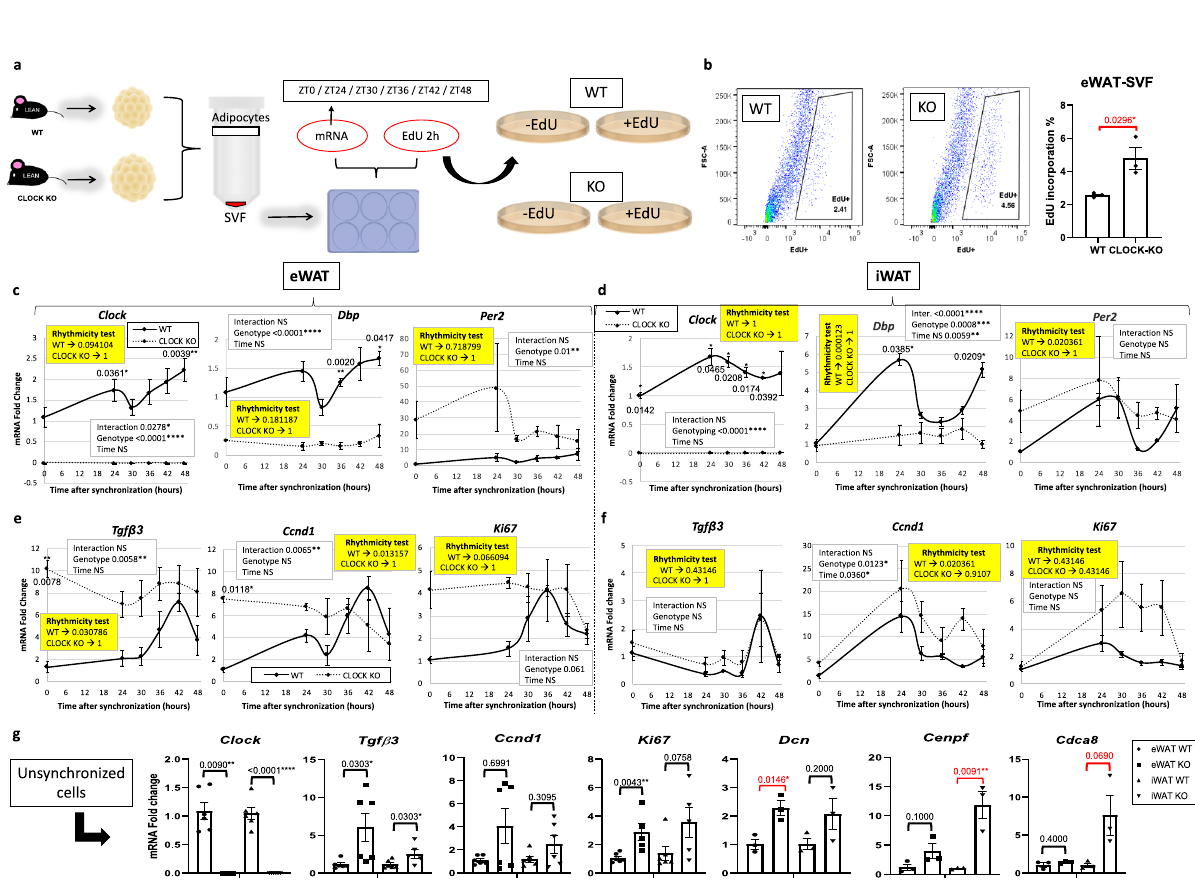
Fig. 6 Clock -de fi ciency induces proliferative markers in epididymal fat (eWAT). a Models of Clock -de fi ciency: eWAT and inguinal fat (iWAT) was collected every 6 h or 5-ethynyl-2 ʹ -deoxyuridine (EdU) was administered at zeitgeber time (ZT) 0 and eWAT and iWAT stromal vascular cell fractions (SVF) were isolated from fat 4 h later. b Energy intake of Clock KO and WT littermates under 12 h light/12 h dark and ad libitum feeding ( n = 6 animals/ genotype). c Home cage locomotion of Clock KO and WT littermates measured by infrared sensors. Bottom white and black lines indicate the light or dark periods, respectively ( b , c ). d Weights of Clock KO ( n = 19 animals) and WT littermates ( n = 10 animals). e Fat pad weights of Clock KO ( n = 29 animals) and WT littermates ( n = 18 animals). f Representative H&E staining of eWAT and iWAT from Clock KO and WT littermates (20X magni fi cation, scale = 100 µ m) and quanti fi cation ( n = 3 animals/genotype, eWAT and n = 4 animals/genotype, iWAT examined over two independent experiments) ( g ). h – j RT-PCR reveals expression of clock ( h ), proliferation ( i ), and adipogenesis ( j ) markers in iWAT (blue = WT, orange = KO) (see also Fig. S7) and eWAT (gray = WT, yellow = KO), from Clock KO and WT littermate mice over 24 h ( n = 3 animals/ ZT). mRNA levels in iWAT for WT at ZT3 set to 1 for all genes. k Western blot reveals expression of phosphorylated hormone-sensitive lipase (P-HSL), total HSL (T-HSL) and β -Tubulin throughout the circadian cycle ( n = 3 animals/ZT) in eWAT (left panel). Quanti fi cation, right panel (gray = WT; yellow = KO). Protein levels from WT mice at ZT3 set to 1. l Representative in vivo fl uorescence activated cell sorting of EdU-positive cells from eWAT (left panel) SVF isolated at ZT4, 4 h following a single EdU injection. Right panel: respective quanti fi cation ( n = 6 animals for Clock KO and n = 4 for WT littermate animals). Data are represented as mean ± SEM. * p < 0.05, ** p < 0.01, *** p < 0.001, **** p < 0.0001. Signi fi cance ( p < 0.05) determined by two-tailed, unpaired t -test in ( d , e ) and for red asterisks; two-tailed Mann – Whitney U test in ( g , l ); and two-way ANOVA followed by Sidak ’ s post hoc test in ( h – k ).